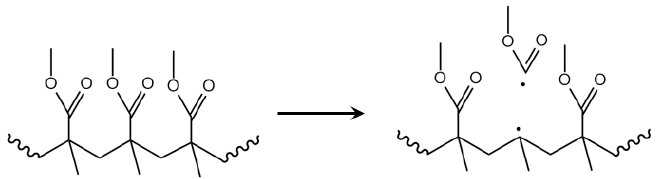
Figure 11 . Fourth thermal degradation initiation reaction based on side-group fission with the methoxy carbonyl group [32].